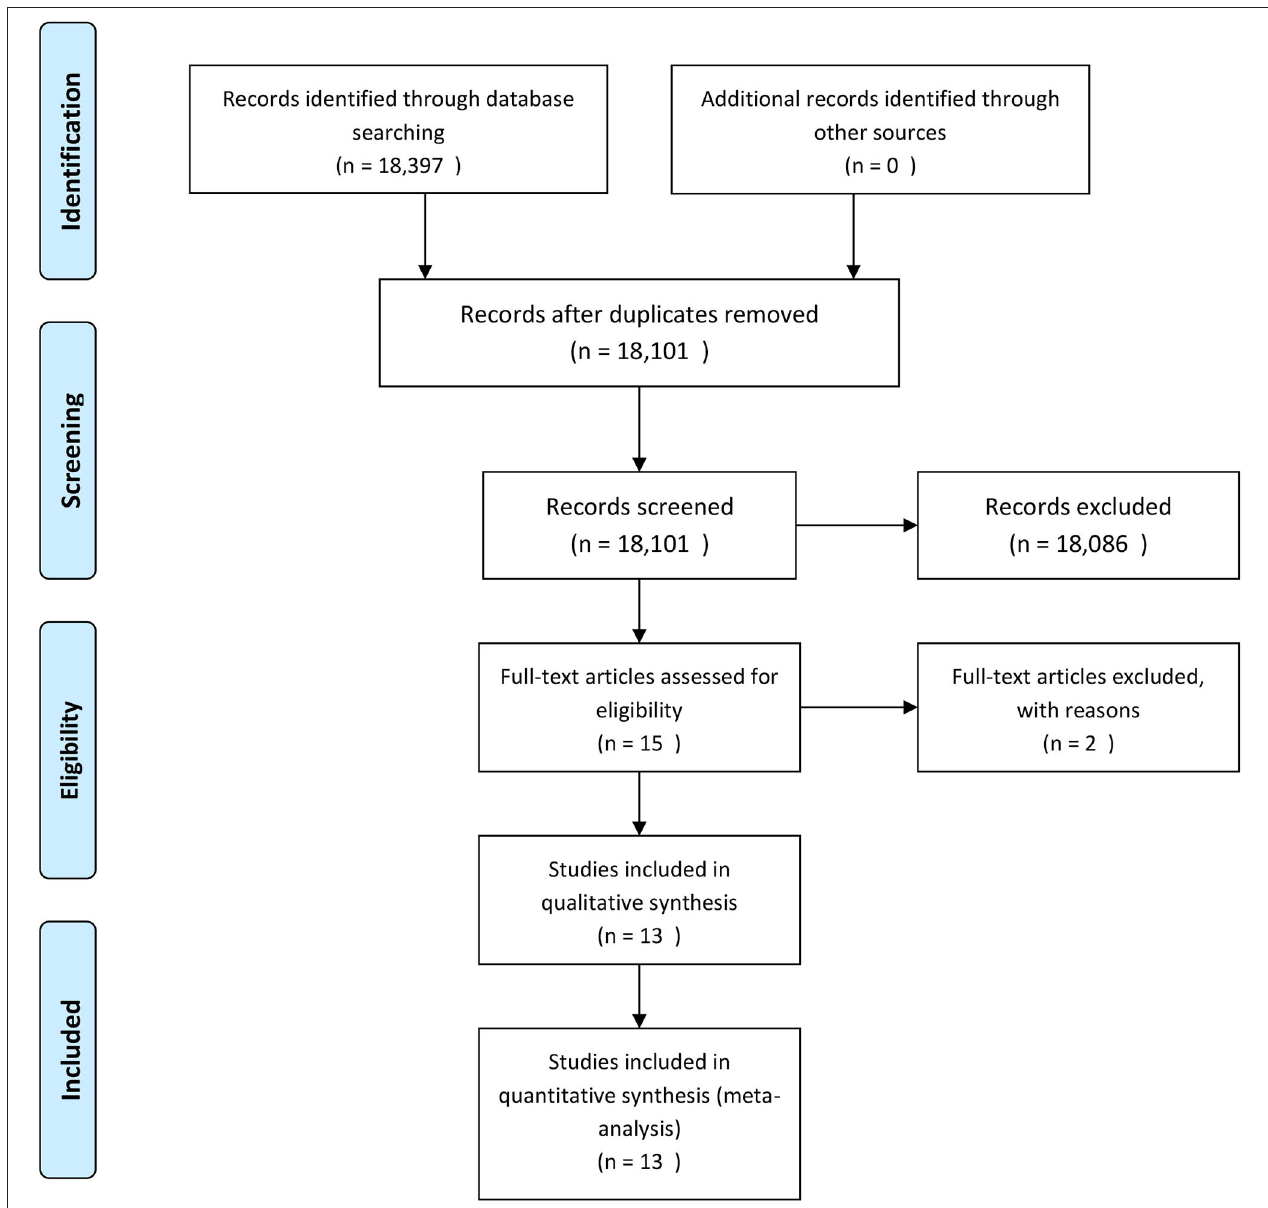
FIGURE 1 | The process of study retrieval, selection and inclusion adopted in the present systematic review and